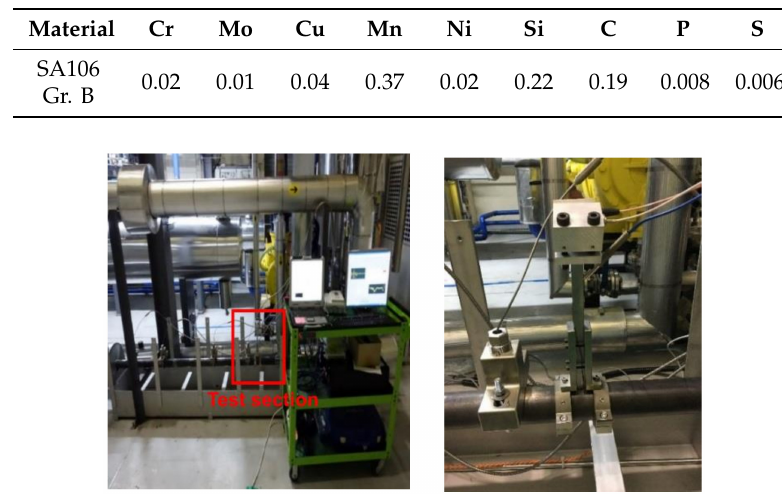
Figure 5. Test section in the flow accelerated corrosion (FAC) facility ( left ) and another type system installed at a test section ( right ).